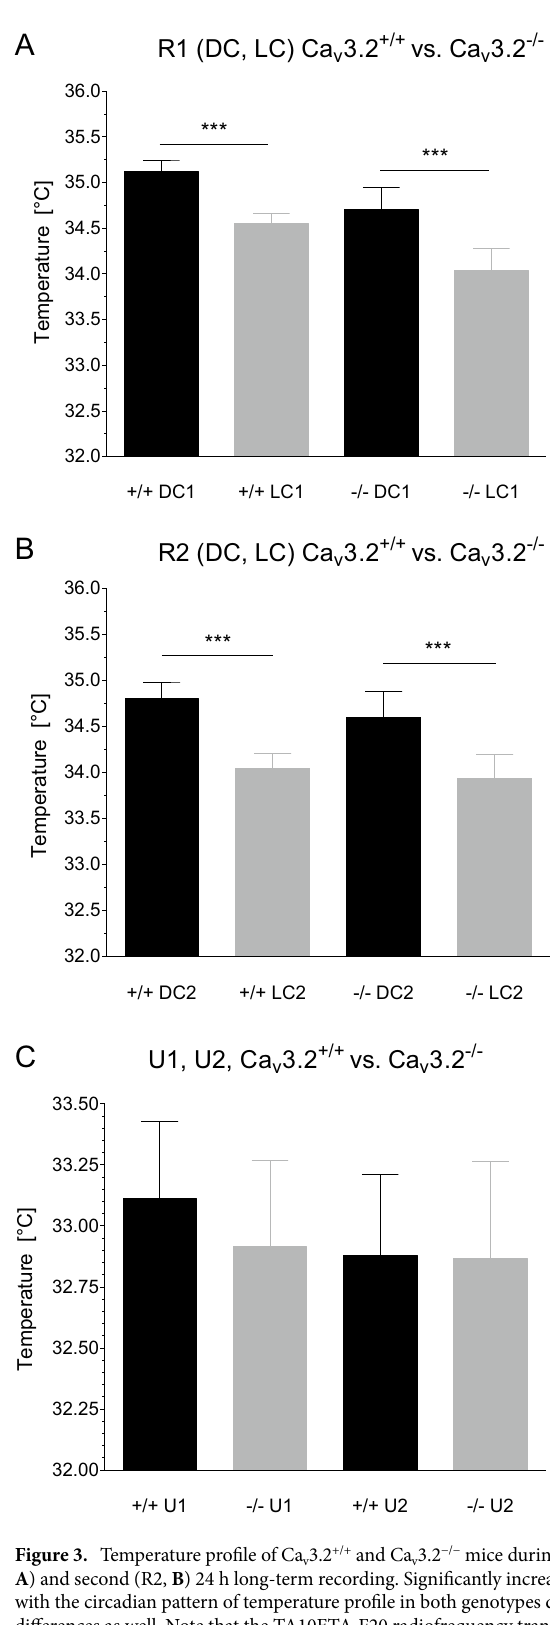
Figure 3. Temperature profile of Ca v 3.2 +/+ and Ca v 3.2 −/− mice during the light cycle (LC) and dark cycle (DC) for the first (R1, A ) and second (R2, B ) 24 h long-term recording. Significantly increased motor activity during the DC (Fig. 2A,B) correlates with the circadian pattern of temperature profile in both genotypes during R1 and R2 recordings exhibiting significant differences as well. Note that the TA10ETA-F20 radiofrequency transmitters are placed subcutaneously and that averaged subcutaneous temperature values do not reflect body core temperature. However, under controlled environmental conditions, subcutaneous temperature profiles reliably parallel body core values. ( C ) Temperature values following both urethane injections (U1, U2, 800 mg/kg i.p. each) exhibited no significant differences within and between both genotypes. Compared to ( A ) and ( B ), mean temperature values are reduced due to hypolocomotion following urethane